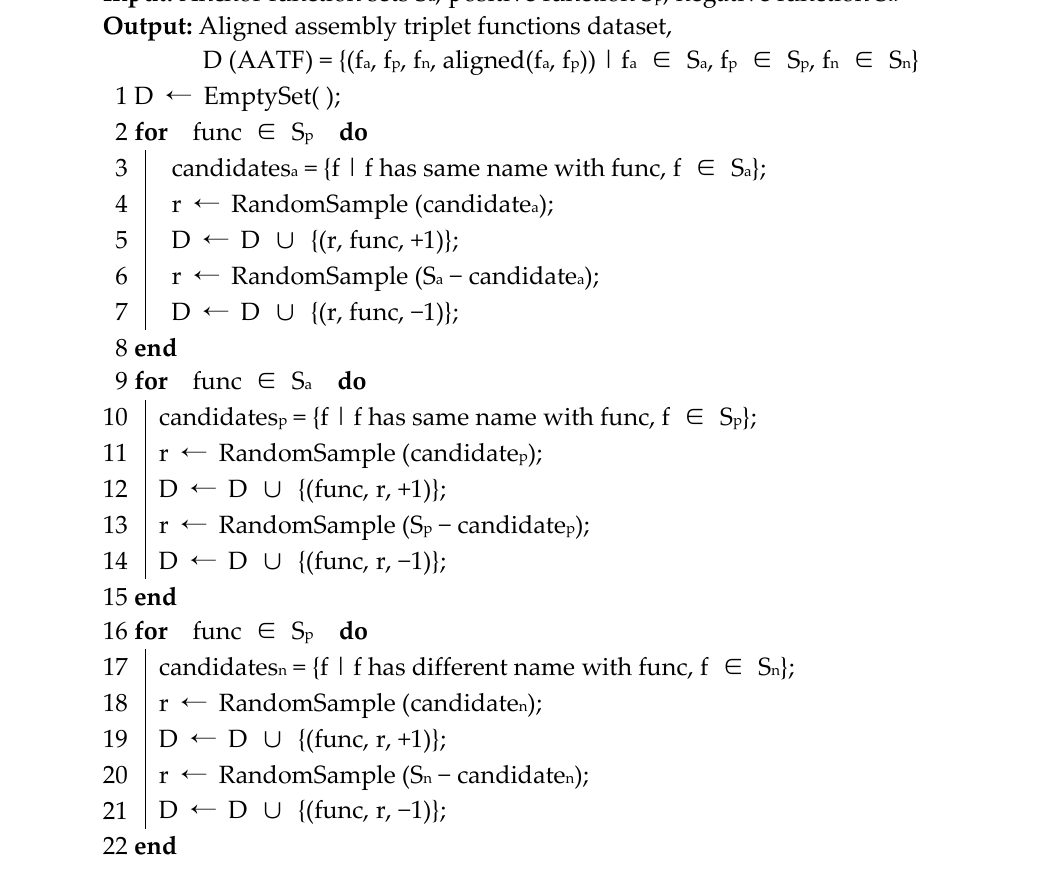
Figure 3. Schematic of aligned assembly generation. Algorithm 1: Aligned Assembly Triplet Functions (AATF) Generation Input: Anchor function sets S a , positive function S p , negative function S n Algorithm 1. Aligned Assembly Triplet Functions (AATF) Generation. Algorithm 1: Aligned Assembly Triplet Functions (AATF)